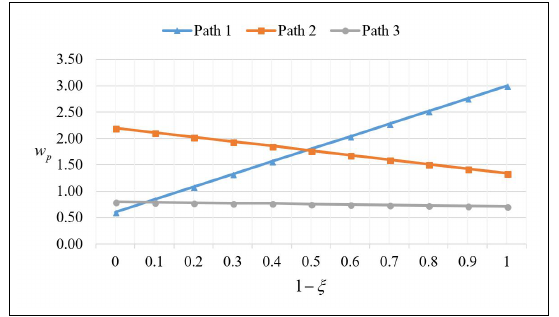
Figure 6. The changes of W p with the changing of the ξ .